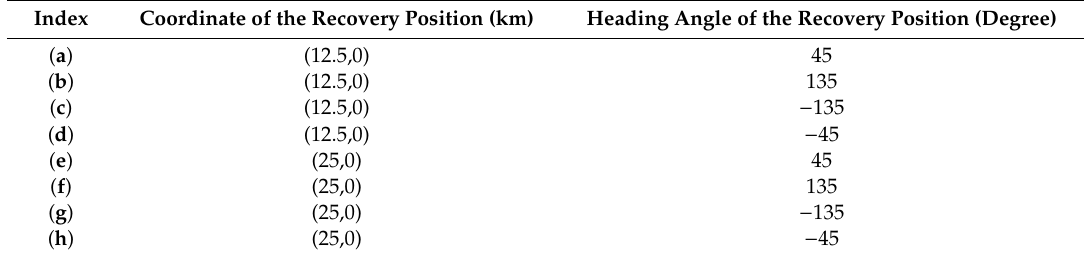
Table 1. Settings of the recovery positions.